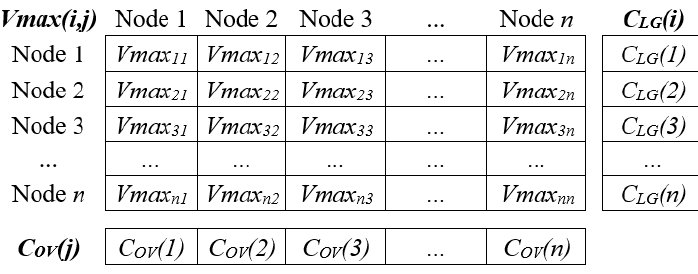
Figure 6. Table of Maximum overvoltages V max ( i , j ) to calculate C OV ( j ) and C LG ( i )